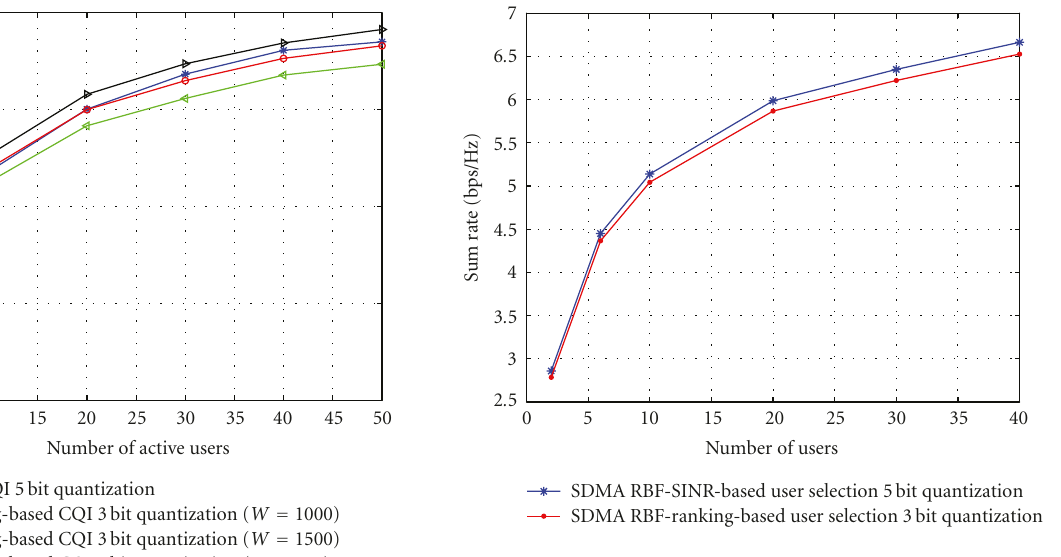
Figure 6: Sum rate as a function of the number of users for multibeam RBF with M = 2 antennas, SNR = 10 dB and W = 1000 slots. The SINR feedback is quantized using B = 5bits, whereas only 3bits are used for ranking-based feedback quantization. The feedback reduction advantage of ranking-based representation is preserved in an SDMA